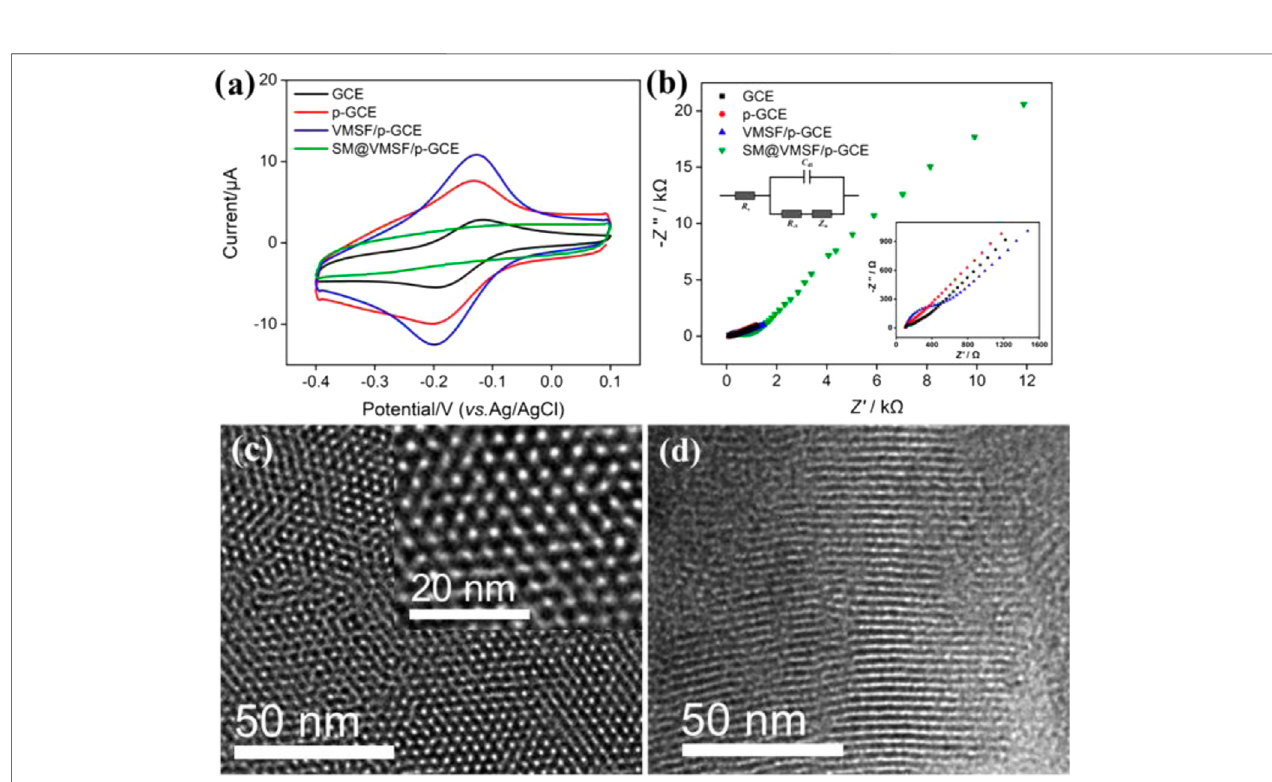
FIGURE 2 | (A) CV curves obtained on GCE, p-GCE, VMSF/p-GCE, and SM@VMSF/p-GCE in PBS (0.01 M, pH = 7.4) containing Ru(NH 3 ) 63+ (0.5 mM). (B) EIS plots obtained in KCl (0.1 M) containing Fe(CN) 63/4 − (2.5 mM). Left and right insets are the equivalent circuit and magni fi ed EIS plots, respectively. (C – D) Top-view, (C) and cross-sectional view (D) of TEM images of the VMSF. The inset is the magni fi ed image.